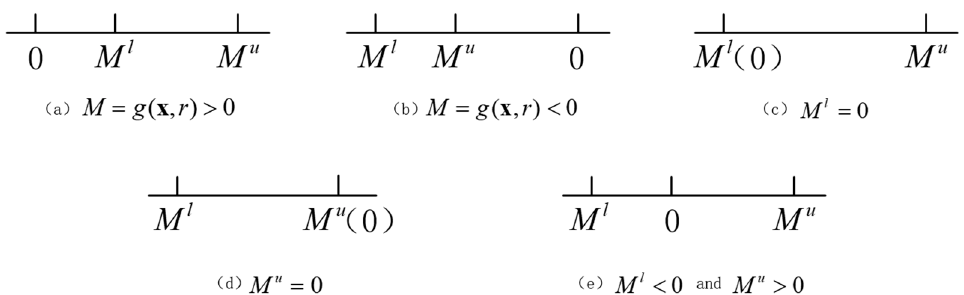
Figure 3. Interval Figure 3. Interval function.